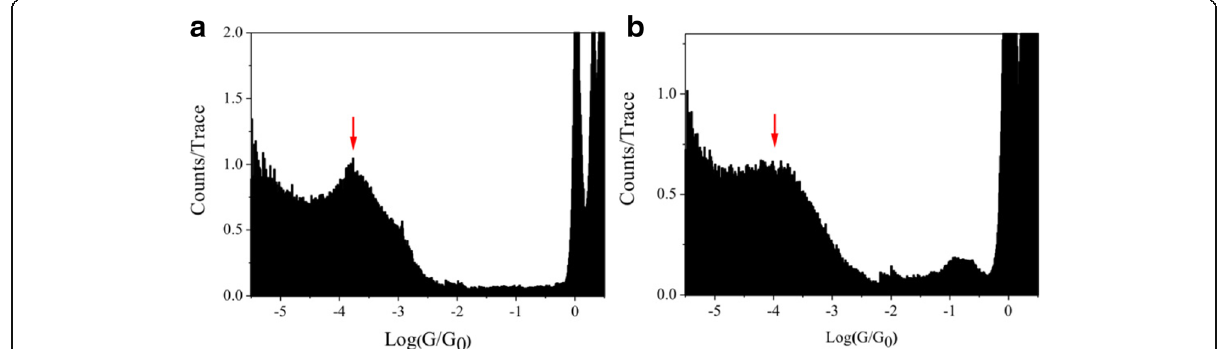
Fig. 3 Single molecular conductance of 1,5-pentanediiodo and 1,6-hexanediiodo with Au electrode. Log-scale conductance histogram of single molecular junctions with a 1,5-pentanediiodo and b 1,6-hexanediiodo